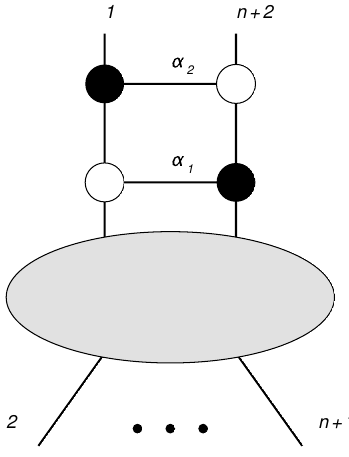
Figure 6 . Double BCFW bridge br (1 , [ n + 2)